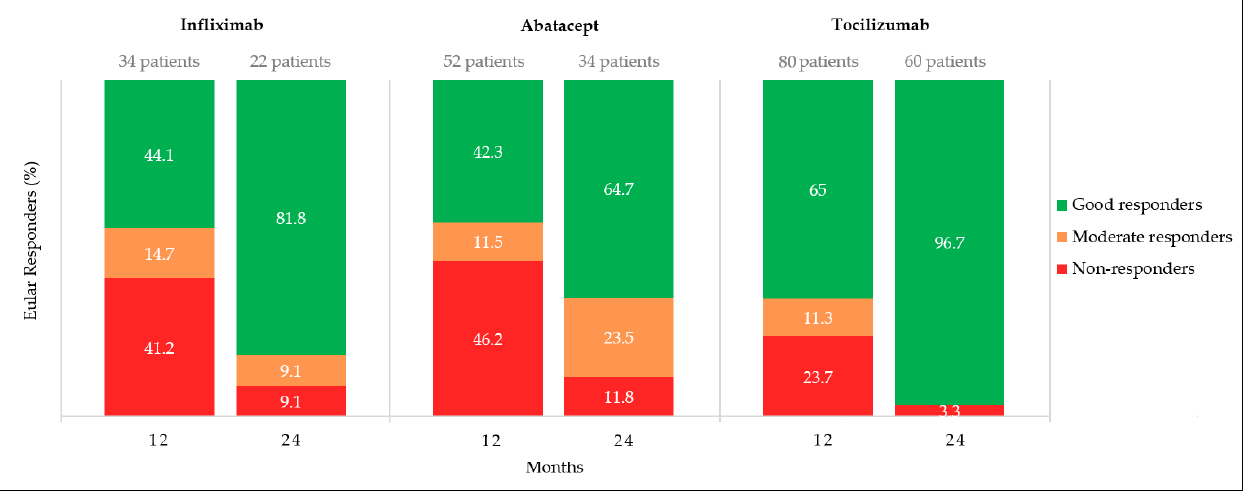
Figure 4. RA patient’s EULAR response rates at 12 and 24 months, according to the bDMARD being administered. being